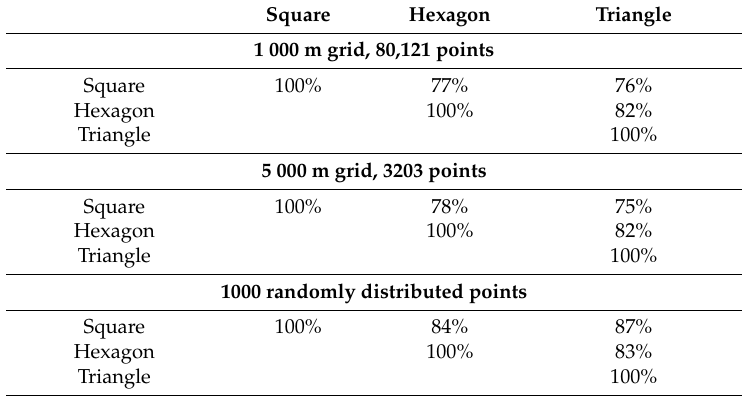
Table 6. Percentage of control points for which the difference between indices of passability does not exceed 0.1.